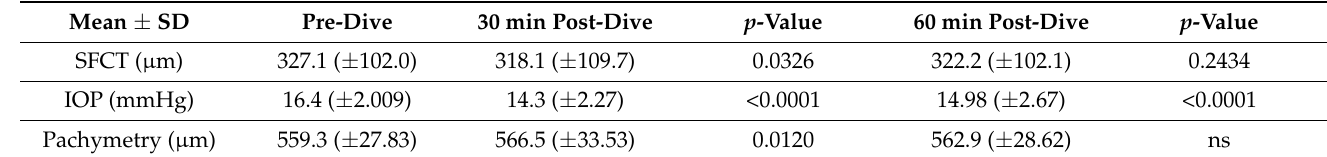
Table 2. Mean measures ± SD of SFCT (expressed in µ m), IOP (expressed in mmHg) and pachymetry (expressed in µ m).